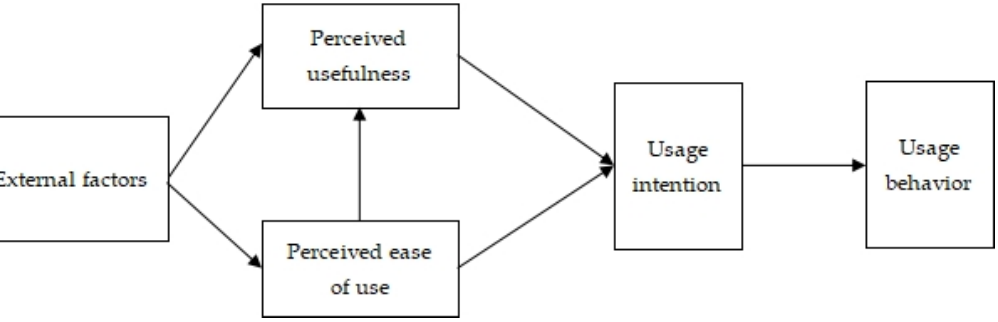
Figure 1. Technology Acceptance Model (TAM).